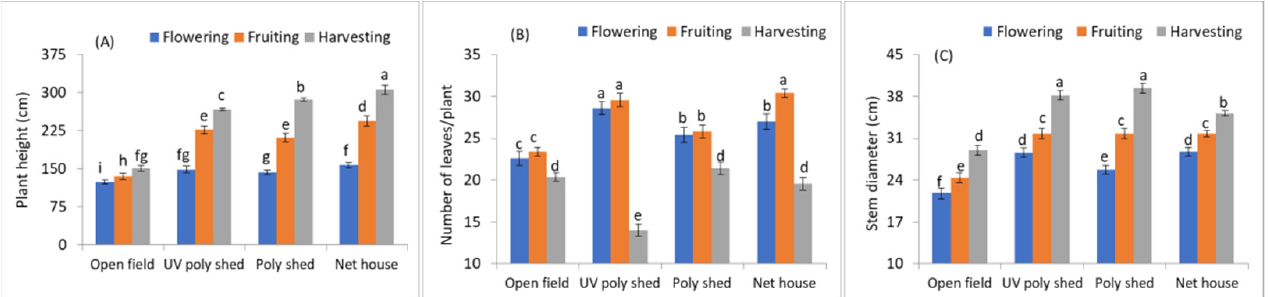
Figure 1. Average plant height (cm) ( A ), number of leaves/plant ( B ) and stem diameter (cm) ( C ), of papaya grown under different sheds and open field condition. Mean ± Standard error (S.E.) ( n = 15). Means with the same lower-case letter are not significantly different at p = 0.05 by Duncan’s multiple range test.